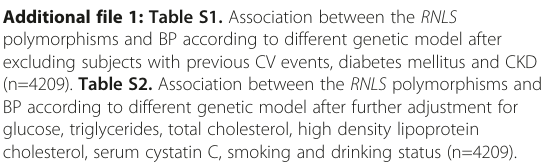
Additional file 1: Table S1. Association between the RNLS polymorphisms and BP according to different genetic model after excluding subjects with previous CV events, diabetes mellitus and CKD (n=4209). Table S2. Association between the RNLS polymorphisms and BP according to different genetic model after further adjustment for glucose, triglycerides, total cholesterol, high density lipoprotein cholesterol, serum cystatin C, smoking and drinking status (n=4209).